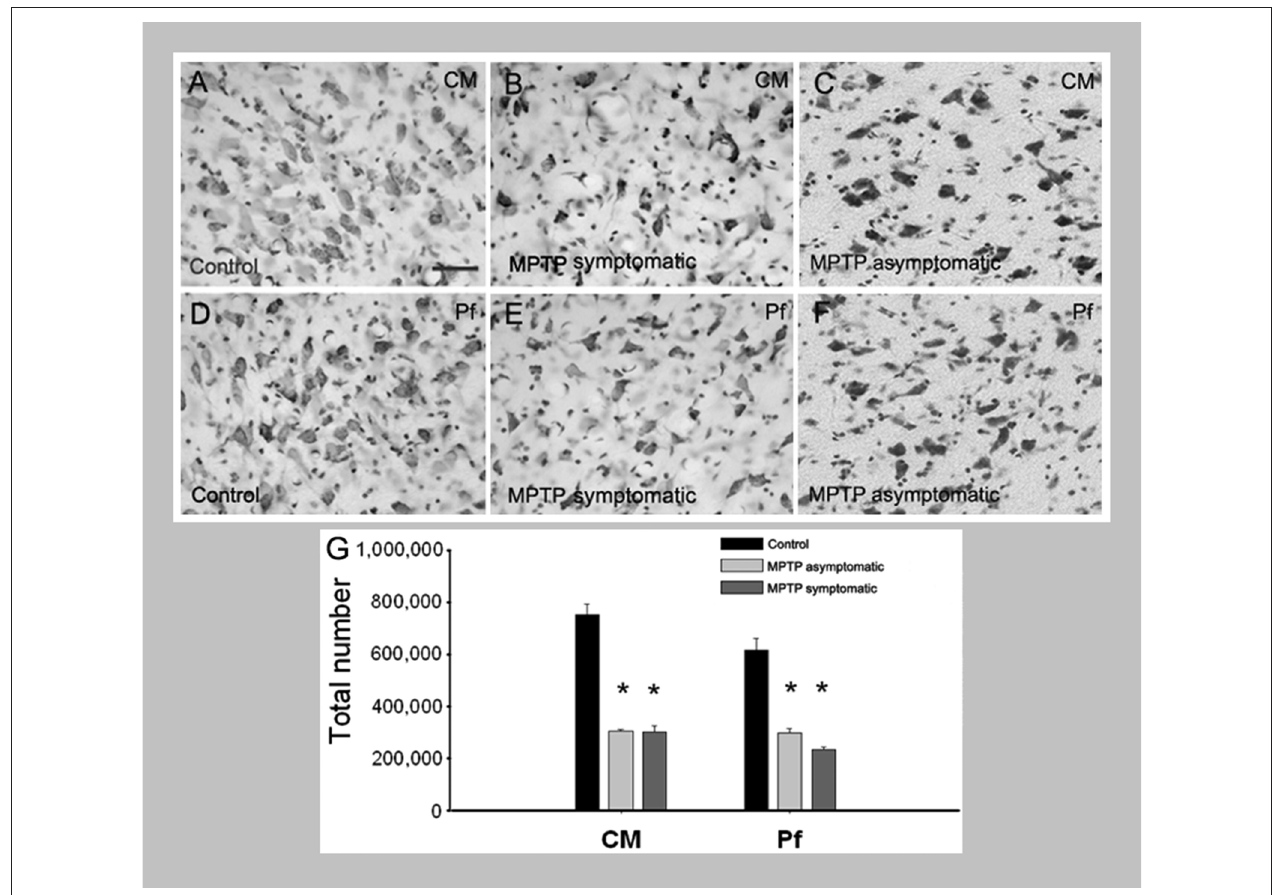
than 80% striatal dopamine loss and displayed moderate to severe Parkinsonism. Note the significant reduction in neuronal density in CM and Pf of both symptomatic and asymptomatic MPTP-treated monkeys. (G) Stereological cell counts demonstrate a significant loss of neurons in both CM and Pf of the two groups of MPTP-treated monkeys compared with